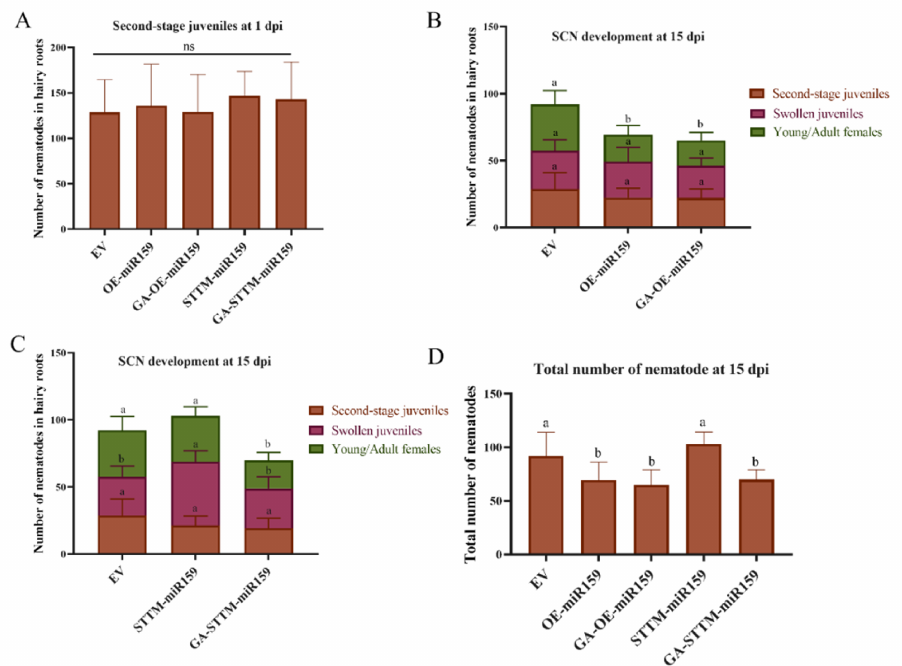
Figure 12. Exogenous GA application recovered soybean resistance to SCN in miR159 silencing soybean hairy roots. ( A ) Penetration assay at 1 dpi. ( B ) Total number of nematodes counted in empty vector, miR159 overexpressing and 10 µ M GA 3 treated miR159 overexpressing hairy roots at 15 dpi. ( C ) Different stage nematodes counted in empty vector, miR159 silencing and10 µ M GA 3 treated miR159 silencing hairy roots at 15 dpi. ( D )Total number of nematodes in all soybean hairy roots at 15 dpi. Multiple statistical comparisons between nematodes in control roots and GA treated roots were made by one-way analysis of variance (ANOVA) followed by LSD post hoc test. Different characters mean significant differences found at p < 0.05 level. ns, not significant. Error bars represent standard deviation from the